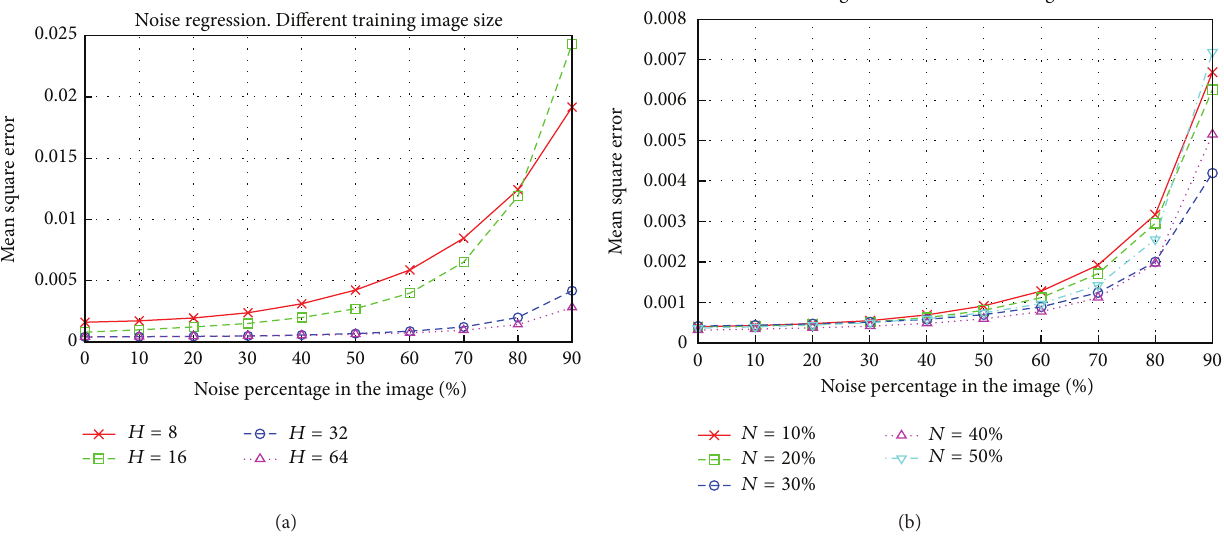
Figure 9: Regression results for different sizes and percentages of noise in training images. Size results were obtained with 𝑁 = 30 % and noise results were obtained using 𝐻 = 32 . The image used was Lenna and the SVM used the Gaussian